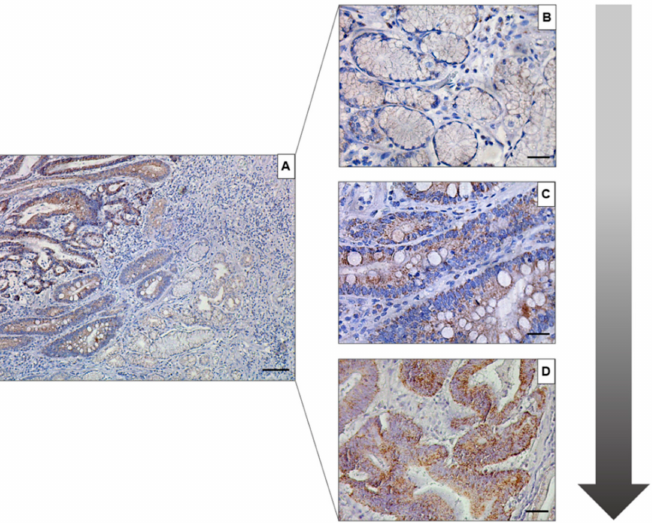
Figure 3. ( A ) Representative image of immunohistochemical detection of Hsp60 in gastric adeno- carcinoma with associated areas of normal mucosa and intestinal metaplasia (magnification 100 × , scale bar 100 µ m). ( B ) Normal gastric mucosa (magnification 400 × , scale bar 20 µ m). ( C ) Intestinal metaplasia (magnification 400 × , scale bar 20 µ m). ( D ) Gastric adenocarcinoma (magnification 400 × , scale bar 20 µ